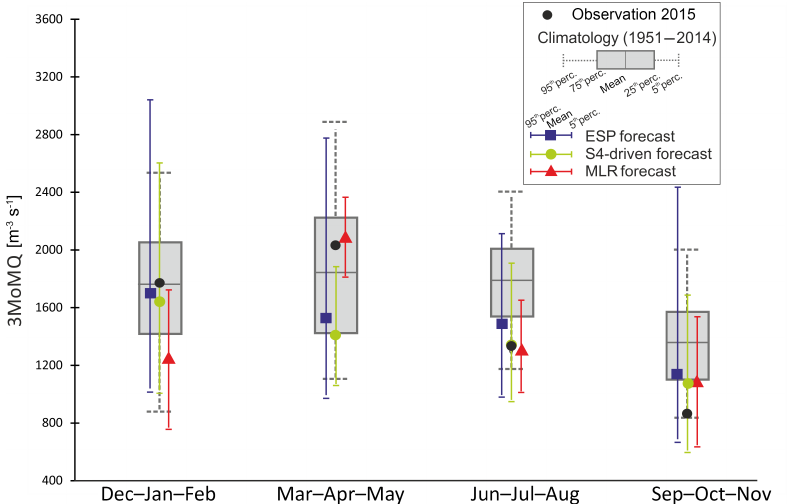
Figure 13. Comparison between the three navigation-related forecast approaches for the monthly mean flow of the next three months 3MoMQ initialized in December 2014, March 2015, June 2015, September 2015 (meteorological seasons 2015) at gauge Kaub/Rhine in relation to the observed values and the climatology